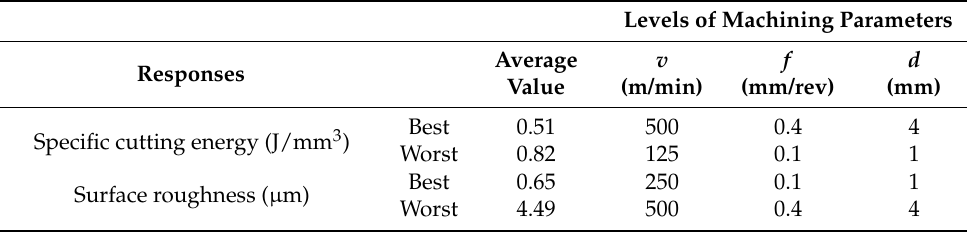
Table 7. Results of confirmatory experiments for conventional speed